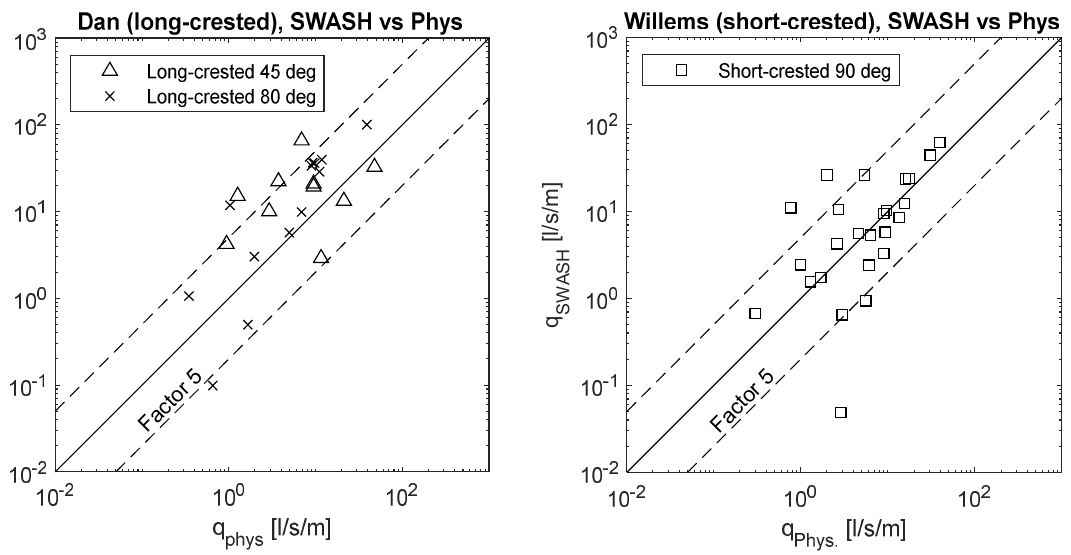
Figure 8. Measured and computed mean wave overtopping discharge ( left : Dan et al., long-crested wave cases, right : Willems et al., short-crested wave cases). Dashed lines show factor 5 overtopping deviation from 1:1 line.